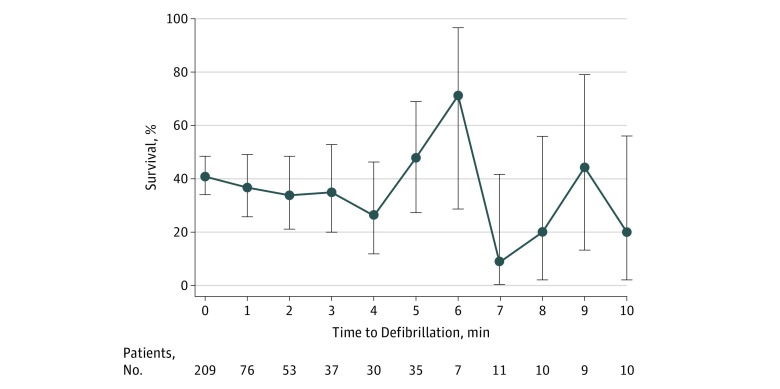
Survival According to Minute of First Defibrillation AttemptPercentage of patients (with 95% confidence intervals [error bars]) who survived to
hospital discharge for each 1 minute elapsed between loss of pulse and time to first
defibrillation attempt.